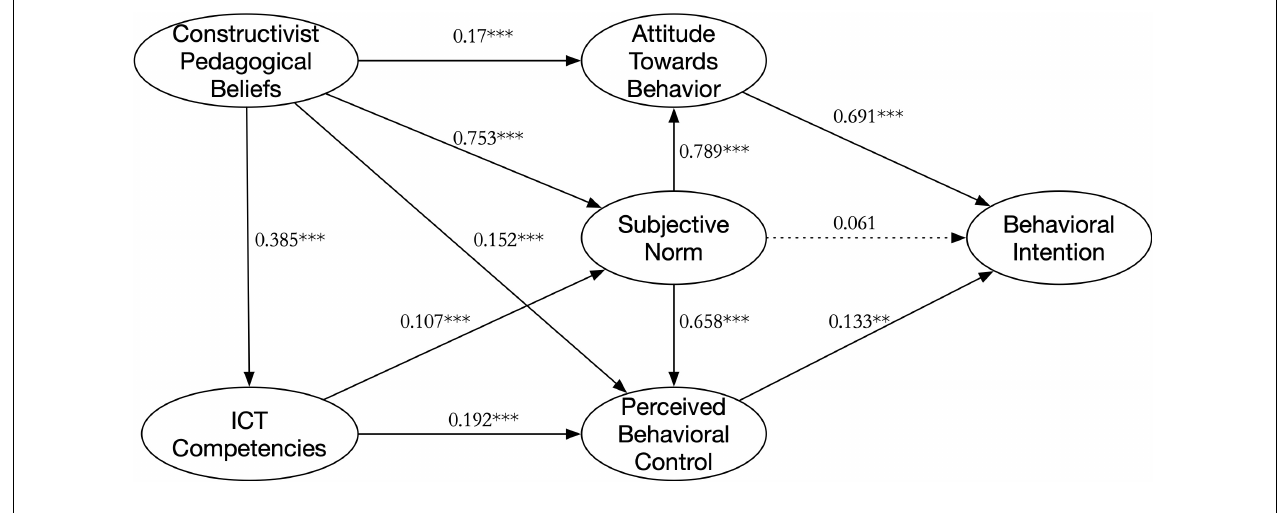
FIGURE 2 | The model of the lower grade group.